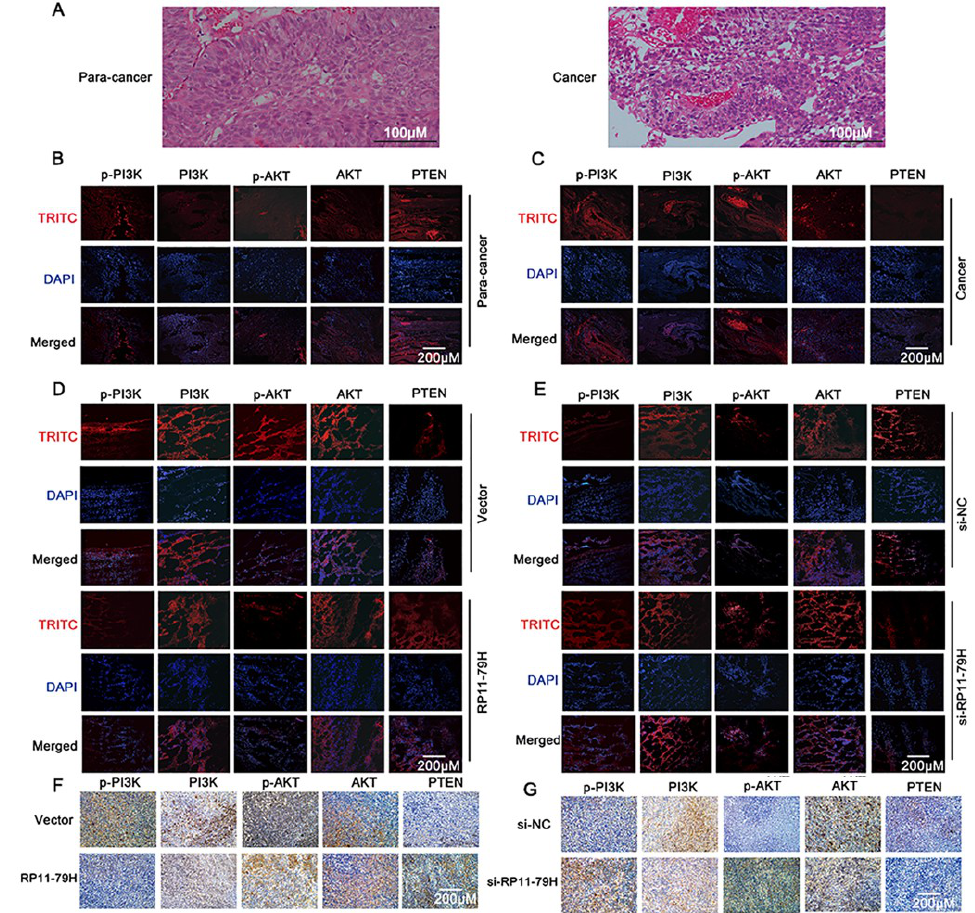
Figure 5. The correlation between the expression of RP11-79H23.3 and the PTEN/PI3K/AKT signaling pathway molecules was detected. ( A ) Representative images of HE-stained human bladder carcinomas and matched para-carcinomas from patients were taken (scale bar, 100 µm). ( B , C ) Immunofluorescence staining was performed for detection of the PTEN and PI3K/AKT signaling pathway molecules in human bladder cancer tissue and matched para-carcinomas (scale bar, 200 µm). ( D – G ) Immunohistochemical and immunofluorescent stainings were performed for examination of the PTEN and PI3K/AKT signaling pathway molecules in tumor tissues from nude mice after ectopic expression and knockdown of RP11-79H23.3 (scale bar, 200 µm).